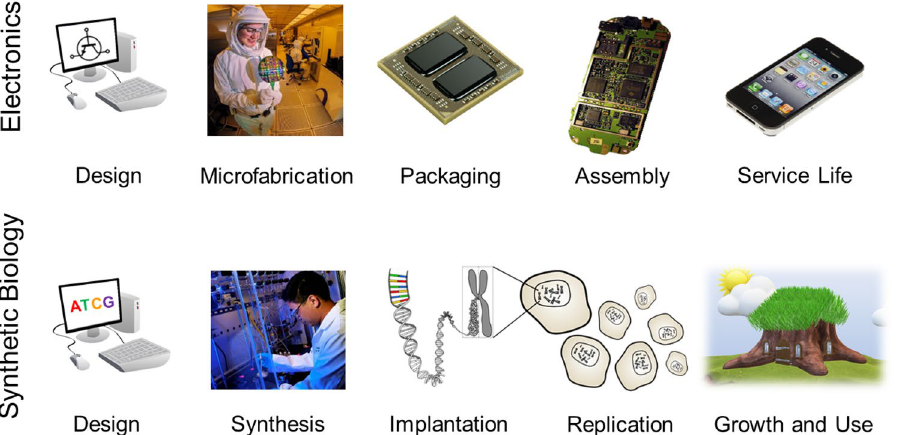
Figure 6. Comparison of life stages of consumer electronics and synthetic biology products. Image credits: Microfabrication: Sandia Labs (CC BY-NC-ND 2.0); Packaging: viagallery.com (CC BY 2.0); Assembly: Uwe Hermann (CC BY-SA 2.0); Service Life: Yutaka Tsutano (CC BY 2.0); Synthesis: Oak Ridge Lab News (CC BY